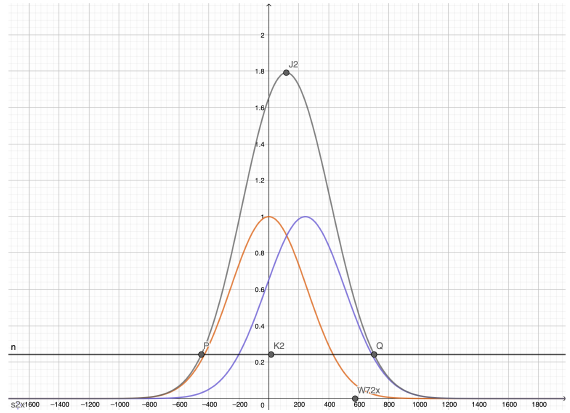
Fig. 6 . Beams at (Bp1-Bp2) and (Bp6-Bp7) superposed in the horizontal direction, The distance (Bp1-Bp2) and (Bp6-Bp7) is 124 mm